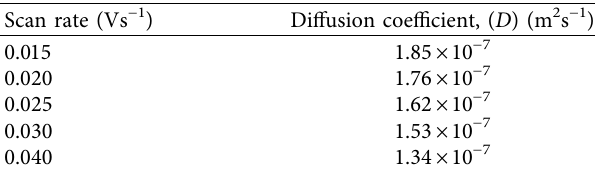
Table 2: Calculated values of the difusion